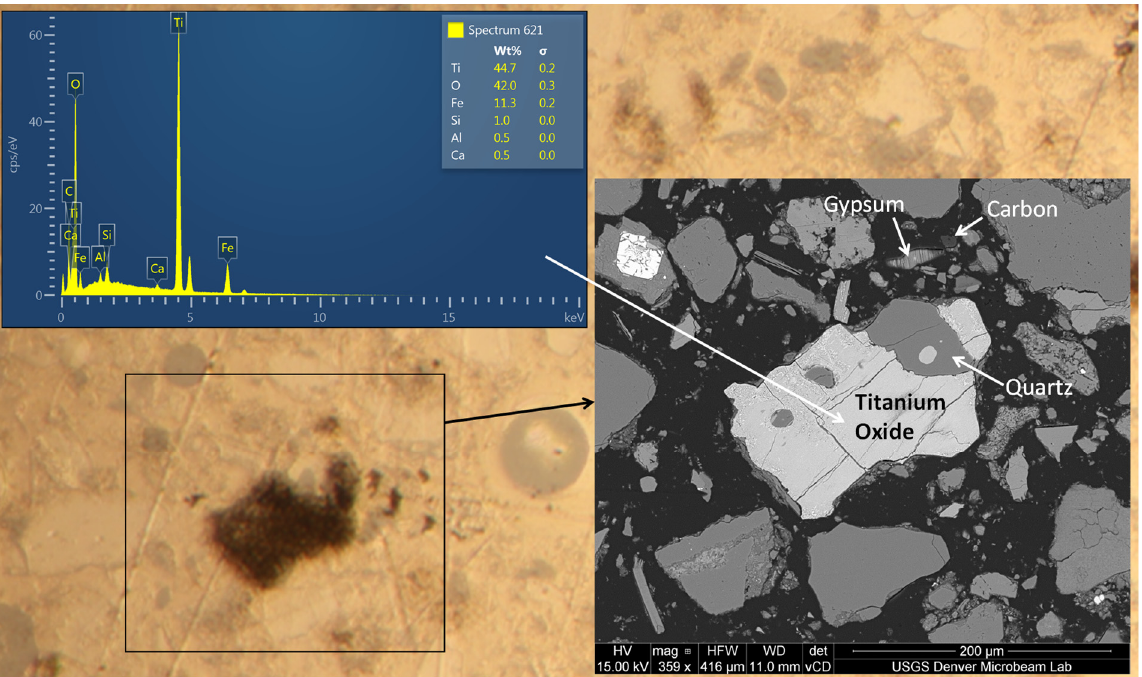
Figure 14. GJAST-14-8 area 5 (Figure 8), thin section plain light background with fission-track overlay at 25% transparency with added SEM-BSE image and titanium oxide EDS spectrum.